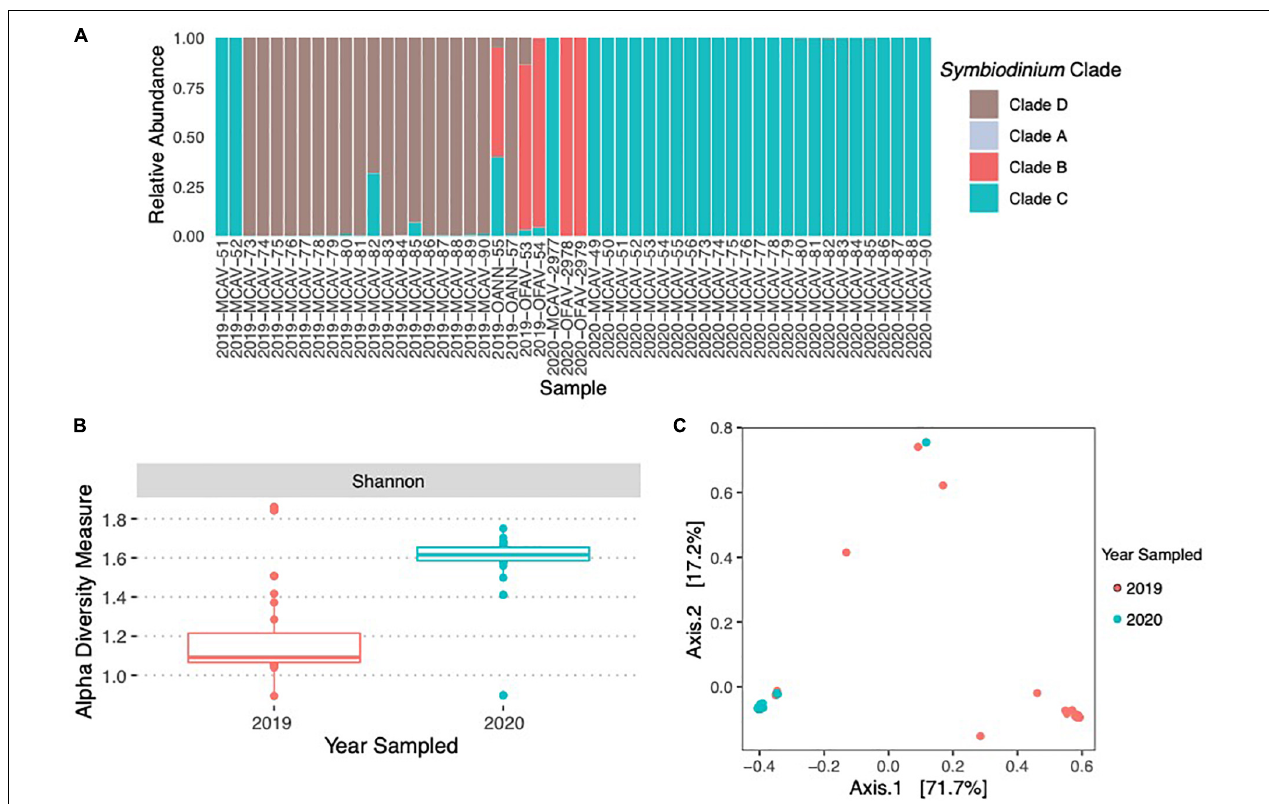
FIGURE 5 | Relative abundance of S ymbiodiniaceae species across the donor diseased corals and the coral fragments used in the experimental trials in 2019 and 2020 (A) . There were significant differences in the alpha diversity of Symbiodiniaceae using Shannon Diversity Index between the 2 years of the experimental trials (B) . There were also significant differences between the community compositions of Symbiodiniaceae between the samples used in 2019 and 2020 (C) .